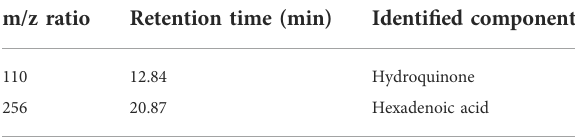
TABLE 1 Intermediate organic compounds detected in samples of photocatalytic degradation of ACET.